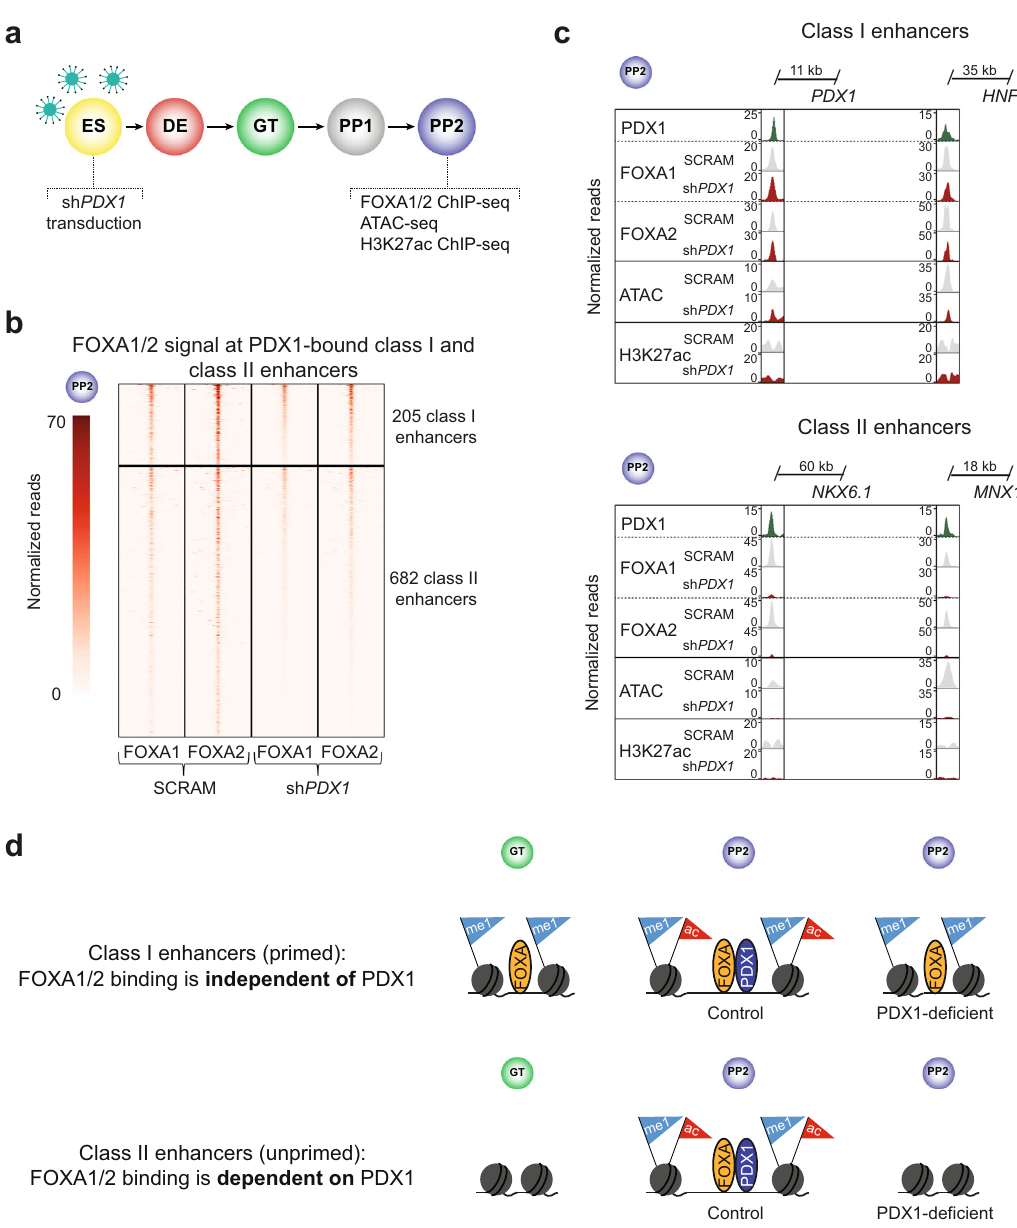
Fig. 5 FOXA1/2 binding at class II enhancers is dependent on PDX1. a Schematic of experimental design for PDX1 knock-down in hESCs and subsequent differentiation into PP2 stage pancreatic progenitors. b Heatmap showing density of FOXA1 and FOXA2 ChIP-seq reads at PDX1-bound class I and class II pancreatic enhancers in hESCs transduced with scrambled control (SCRAM) or PDX1 shRNA (sh PDX1 ) in PP2. Heatmap is centered on FOXA1 and FOXA2 peaks, respectively, and spans 5 kb. c Genome browser snapshots showing PDX1, FOXA1, and FOXA2 ChIP-seq, ATAC-seq, and H3K27ac ChIP-seq signal at class I enhancers near PDX1 and HNF1B and class II enhancers near NKX6.1 and MNX1 in PP2. Approximate distance between enhancer and gene body is indicated. d Schematic illustrating distinct modes of FOXA TF recruitment at class I and class II pancreatic enhancers. FOXA1/2 recruitment depends on the lineage-determining TF PDX1 at class II enhancers. Both enhancer classes require PDX1 for activation. All ChIP-seq and ATAC-seq experiments, n = 2 replicates from independent